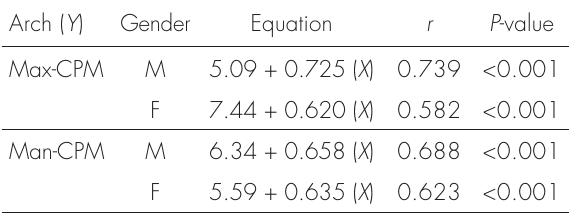
Table IV. New regression equations for the estimation of mesiodistal dimensions of canine and premolar derived for both males and females of the Australian population.